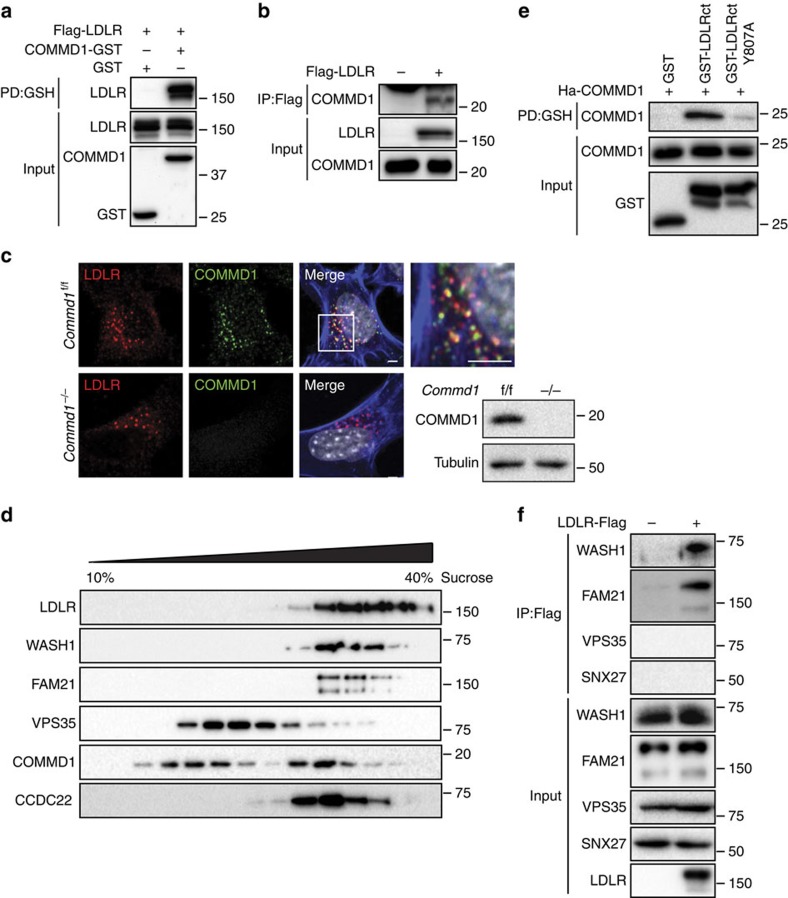
LDLR associates with COMMD1 and the WASH complex.(a) Human embryonic kidney 293T (HEK293T) cells were transfected with constructs expressing Flag-LDLR with either COMMD1-GST or GST alone. Interaction with COMMD1 was detected via pull-down assay using glutathione sepharose beads. (b) HEK293T cells were transfected with Flag-LDLR vector, and interaction with endogenous COMMD1 was detected by immunoprecipitation with rabbit anti-Flag-antibody. (c) Colocalization of LDLR (red) and COMMD1 (green) in Commd1f/f MEFs examined by immunofluorescence staining. Representative images are shown; scale bar, 5μm. LDLR (red) and COMMD1 (green) was stained in COMMD1-deficient MEFs (Commd1−/−) and imaged by confocal fluorescence microscopy. COMMD1 levels in Commd1f/f and in Commd1−/− MEFs determined by immunoblot analysis. (d) Liver of a WT chow-fed mouse was homogenized and loaded on a continuous 10–40% sucrose gradient. Fractions were separated by ultracentrifugation and immunoblotted using antibodies against COMMD1, LDLR, WASH1, FAM21, VPS35 and CCDC22. The figure represents results of three independent experiments. (e) HEK293T cells were transfected with Ha-COMMD1 construct together with GST alone, GST-LDLRct (GST-tagged cytosolic domain of LDLR) or GST-LDLRct Y807A (GST-tagged mutated cytosolic domain of LDLR). Pull-down assay was performed to study the interaction between LDLRct and COMMD1. (f) Lysates of Flag-LDLR-transfected HEK293T cells were used for immunoprecipitation assays. Immunoprecipitates were washed, separated by SDS–polyacrylamide gel electrophoresis and immunoblotted as indicated.